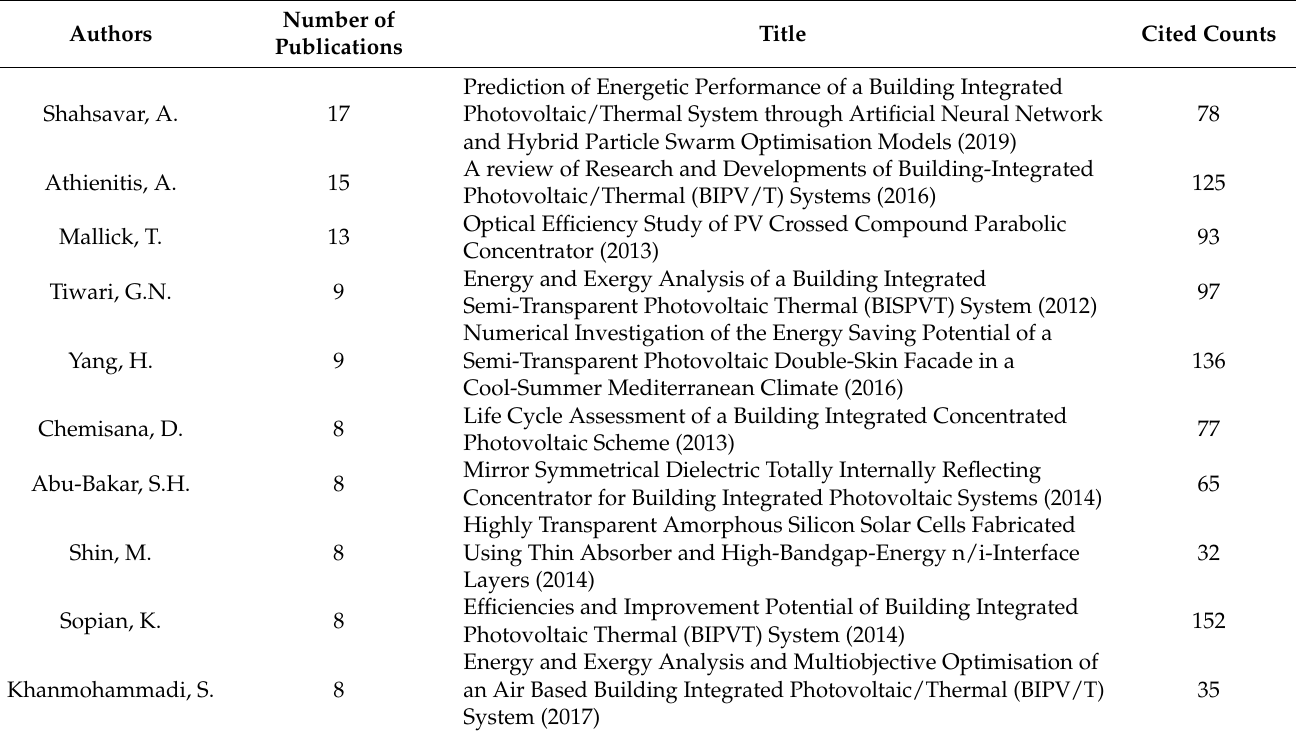
Table 2. The top 10 authors in the number of publications and their top five cited